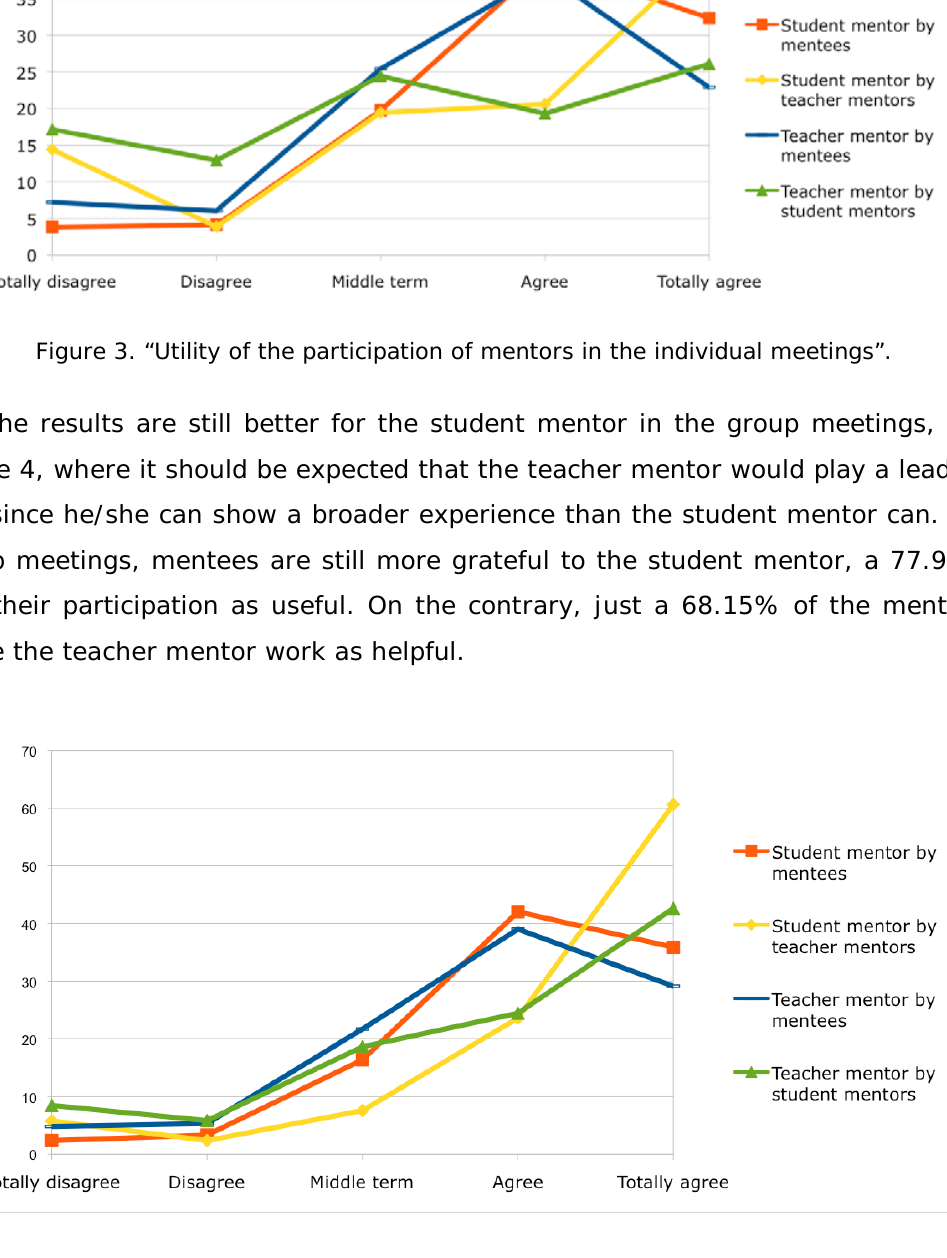
Figure 4. Utility of the collaboration of mentors during the group